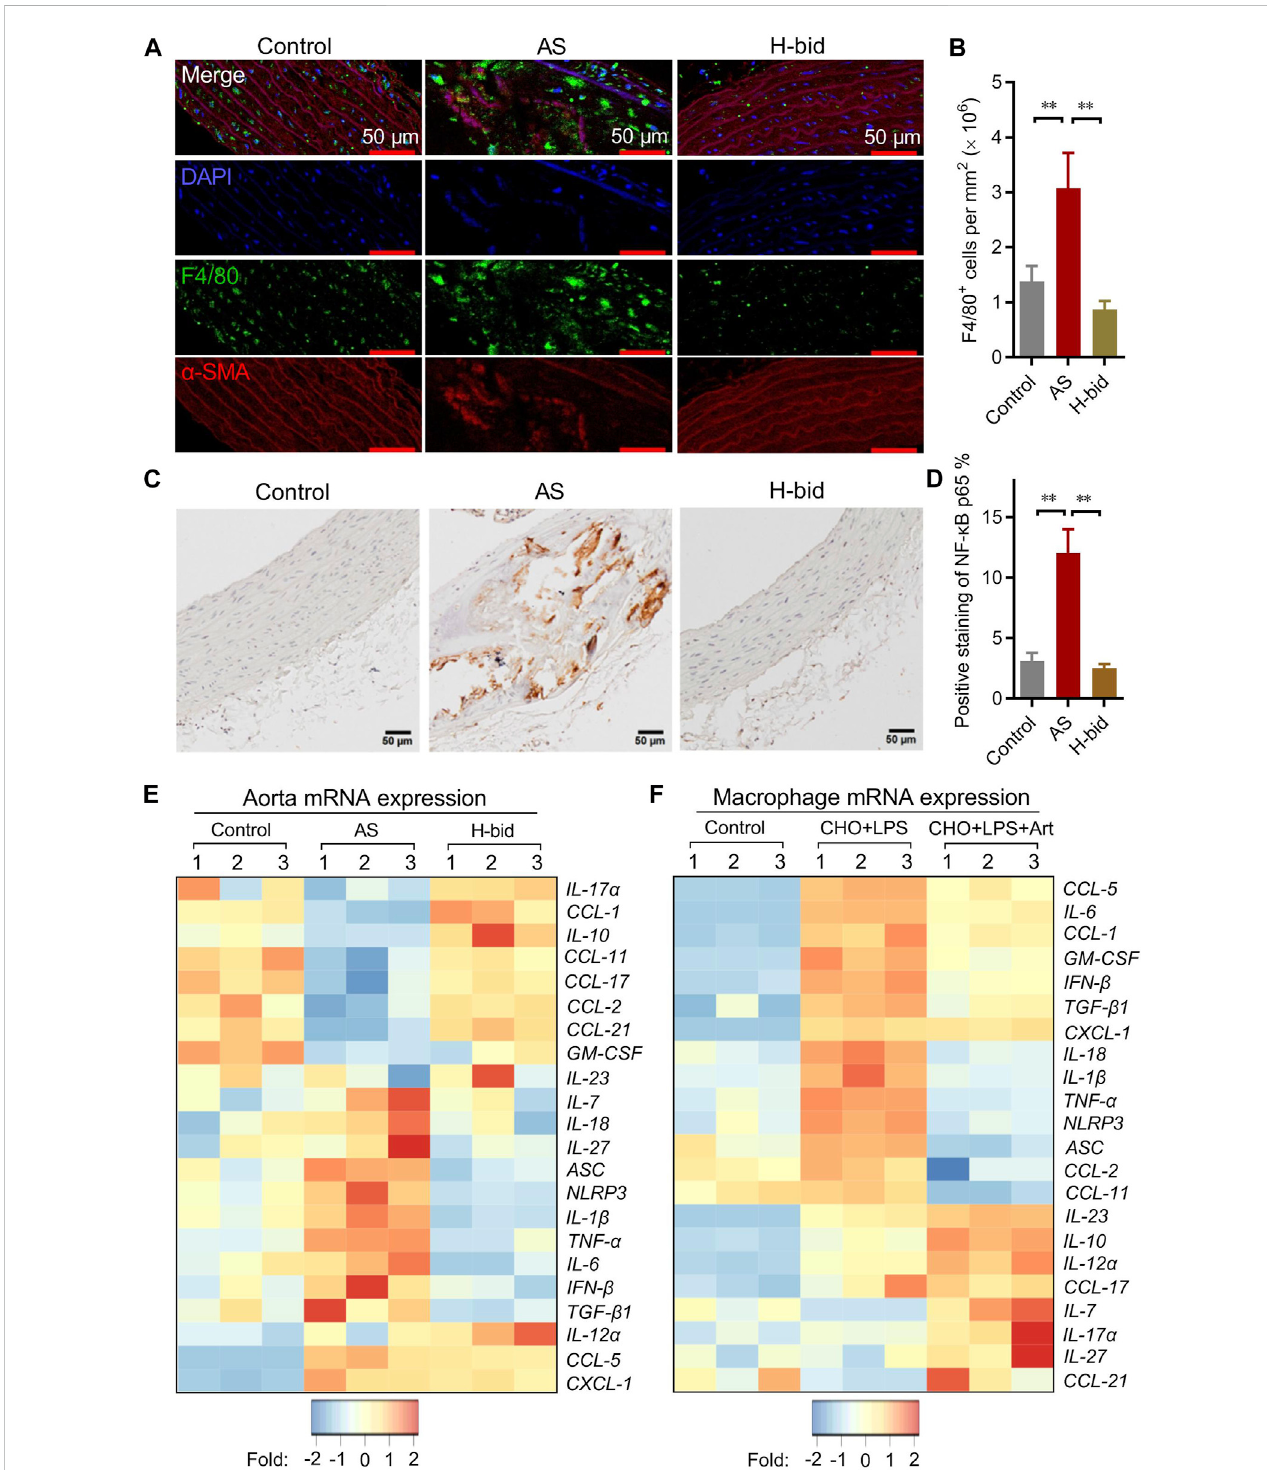
FIGURE 3 Art attenuates arterial in fl ammation in AS rats. (A – B) Immuno fl uorescence staining of arterial sections. Paraf fi n sections were probed with antibodies against F4/80 (green) or α -SMA (red), followed by DAPI (blue) staining. Confocal imaging was performed using a confocal microscope, and the F4/80 + cells (macrophages)weremeasuredusing ImageJ(Bar =50 μ m; n =5). (C – D) IHCstainingofarterialsections.Paraf fi nsectionswereprobed byantibodiesagainst theNF- κ Bp65subunitusingtheIHCmethod andobserved underalightmicroscope, andthepercentage ofNF- κ Bp65-positive stainingwascalculated using ImageJ (Bar = 50 μ m; n = 5). (E) mRNA levels of a class of in fl ammatory cytokines and chemokines of aortas from atherosclerotic rats detected by PCR array ( n = 3). (F) PCR array analysis of RPMs treated by water-soluble cholesterol (CHO; 100 μ g/mL) plus LPS (10 ng/mL) with or without the presence of artesunate (Art; 20 μ g/mL) for 1 h ( n = 3). ** p <